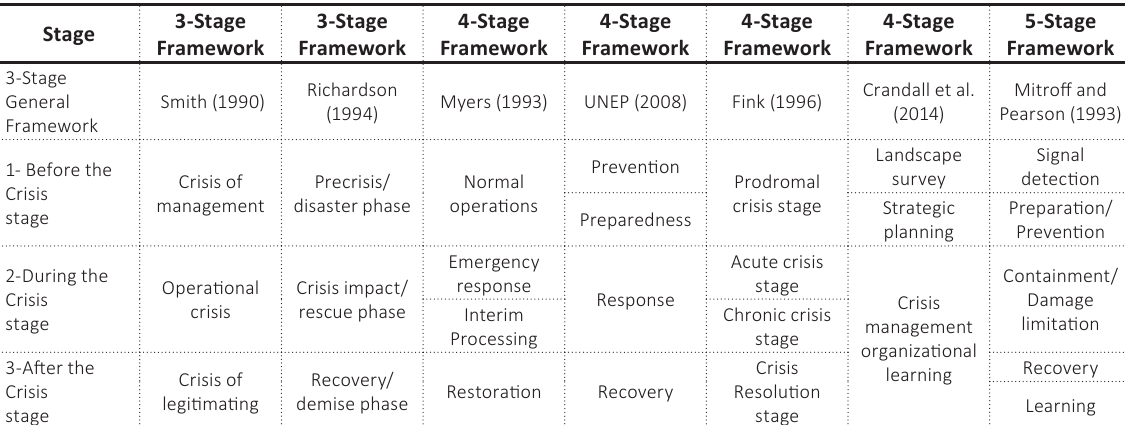
Table 1. Frameworks for crisis management stages